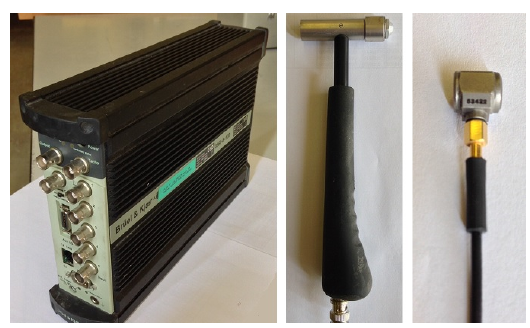
Figure 1. Experimental set-up for the Resonance